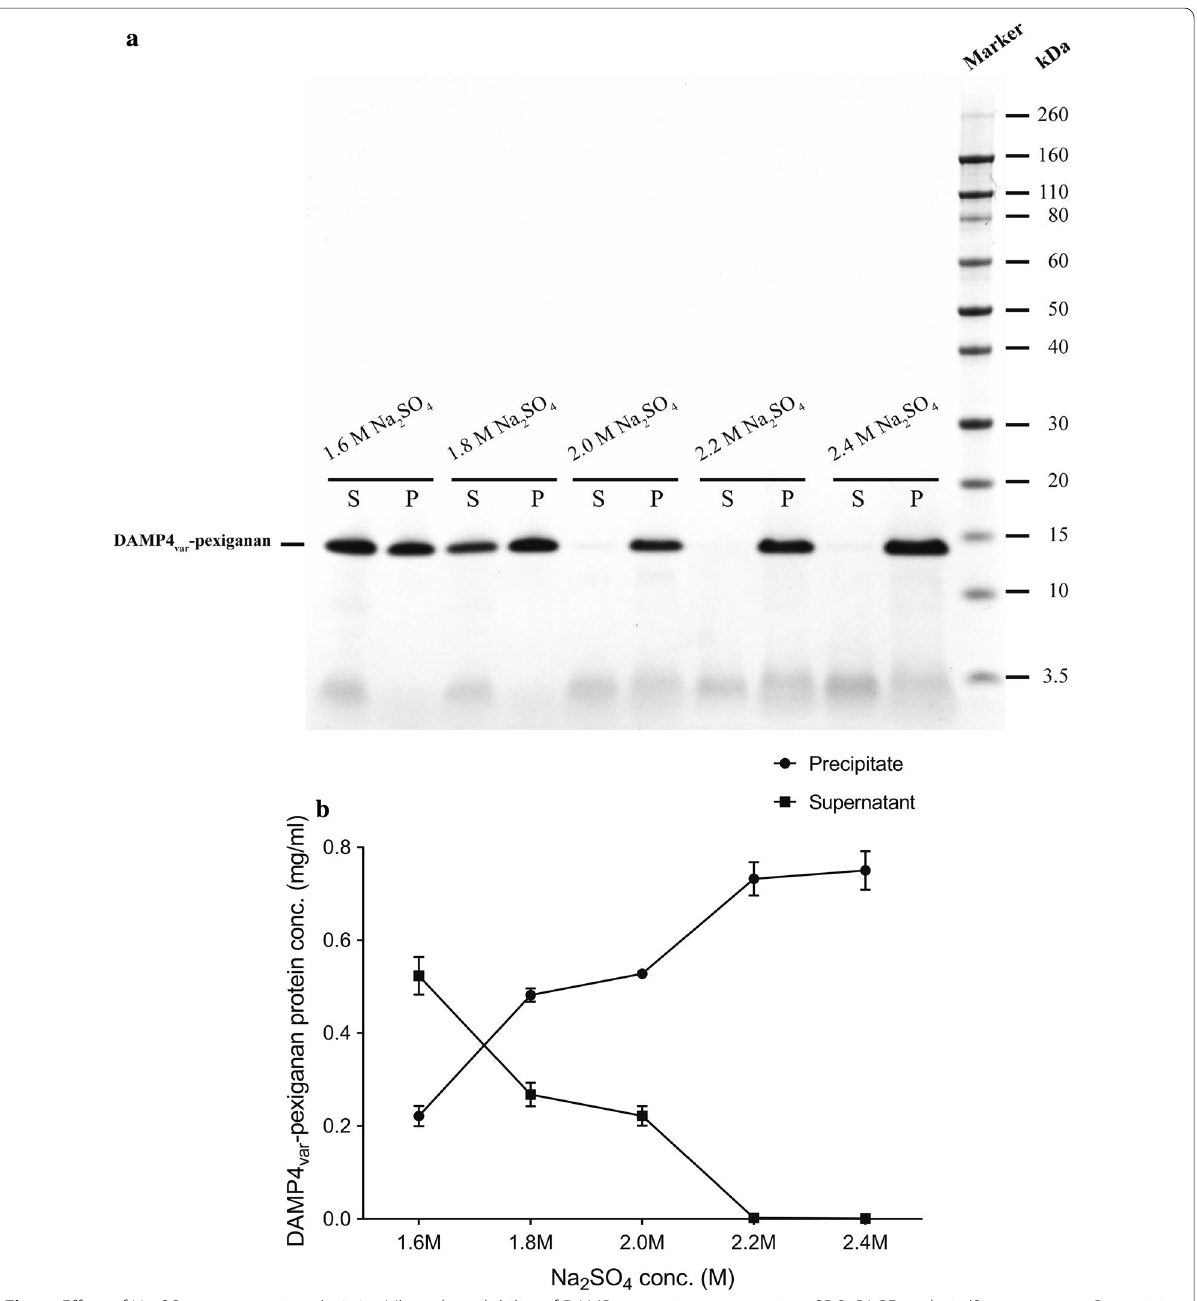
Fig. 4 Effect of Na 2 SO 4 concentrations (1.6–2.4 M) on the solubility of DAMP4 var ‑pexiganan protein. a SDS–PAGE analysis (S, supernatant; P, precipi‑ tate). b The concentrations of DAMP4 var ‑pexiganan protein in both the supernatant and the solubilized